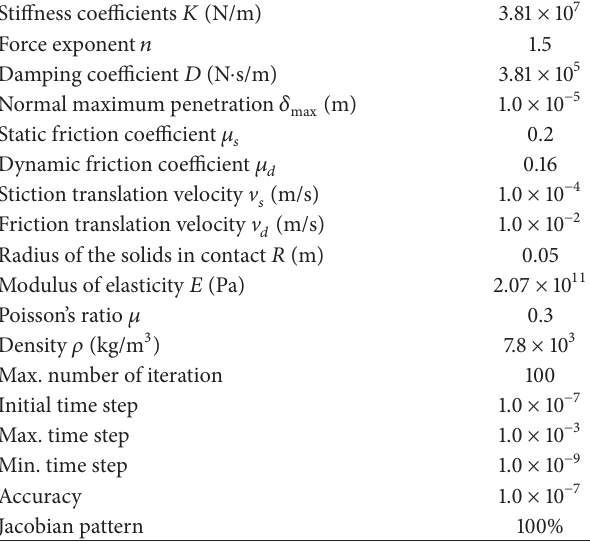
Table 3: Simulation